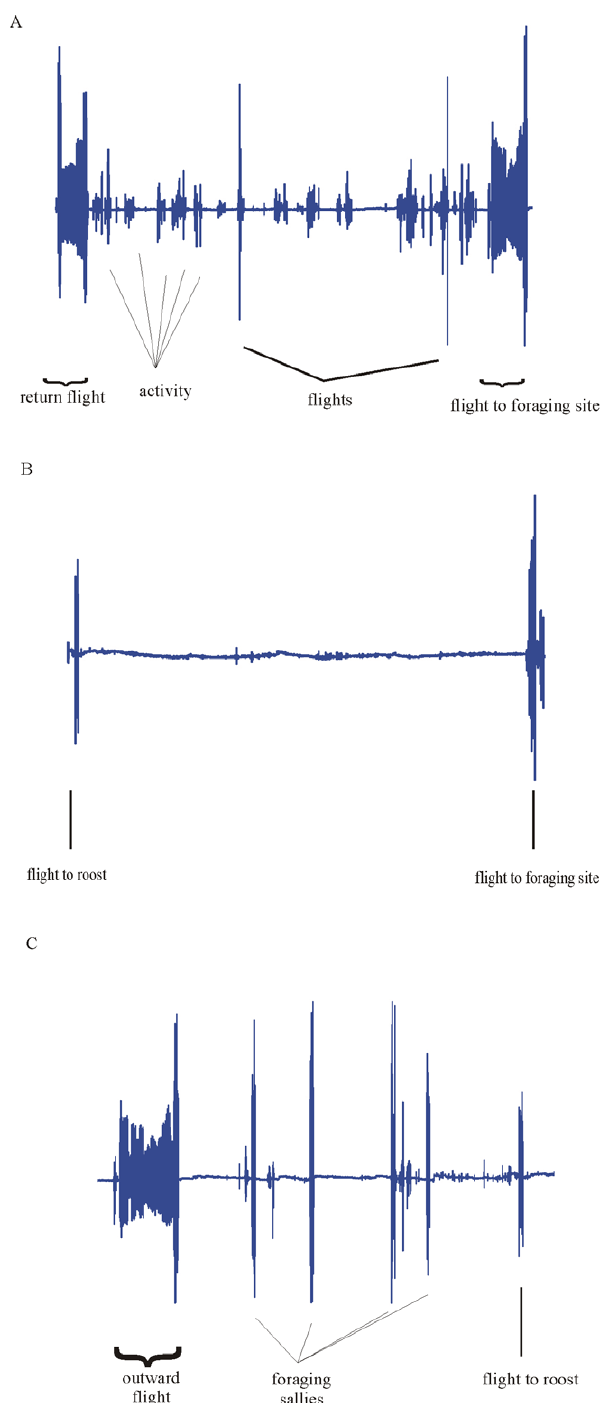
Figure 4. Acceleration trace of bird carrying tag 19. Recorded on a single (up-down) axis a) while roosting in the Cueva del Gua´charo, b) while roosting in the forest and c) a trace of night time activity.